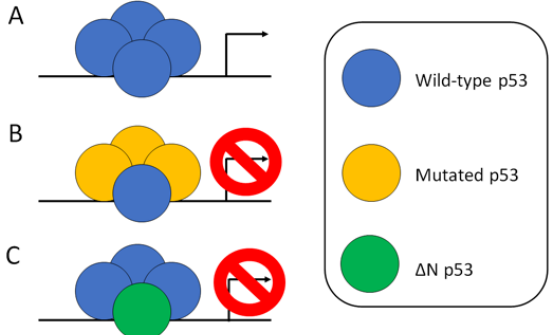
Figure 1. Effects of mutant p53 and Δ Np53 on the transactivity of wild type p53. ( A ) Wild type p53